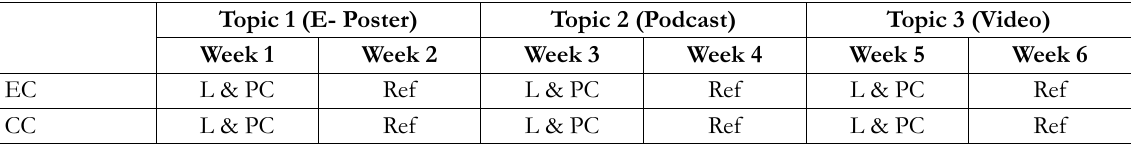
Table 2. Time Distribution of the study plan in the Experimental Class (EC) and Control Class